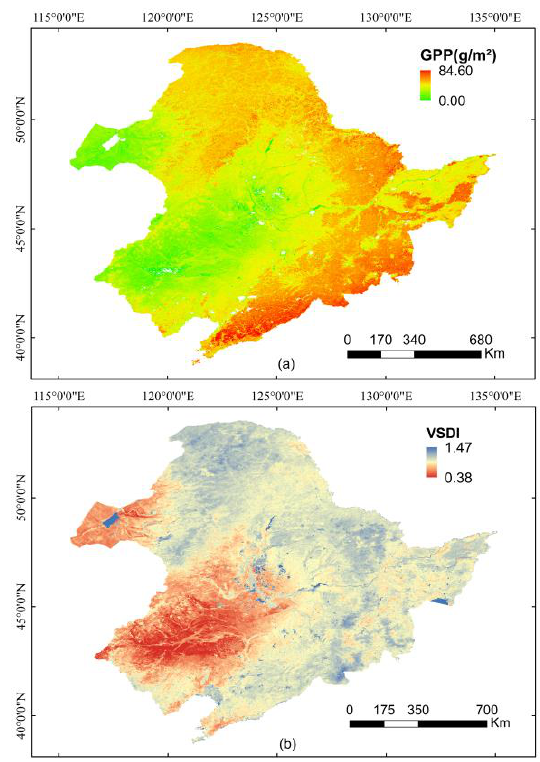
Figure 2. The distribution of GPP(a) and VSDI(b) in NEC